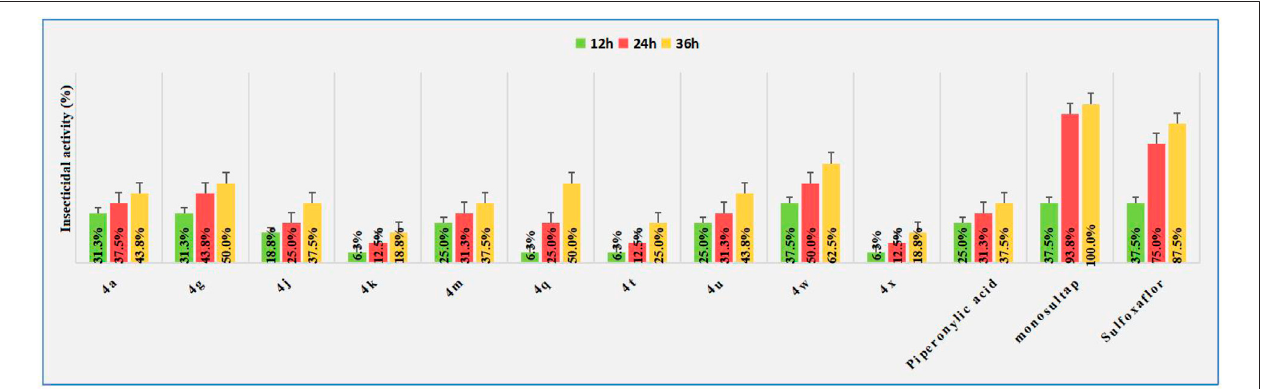
FIGURE 2 | Insecticidal activity against Spodoptera frugiperda of title